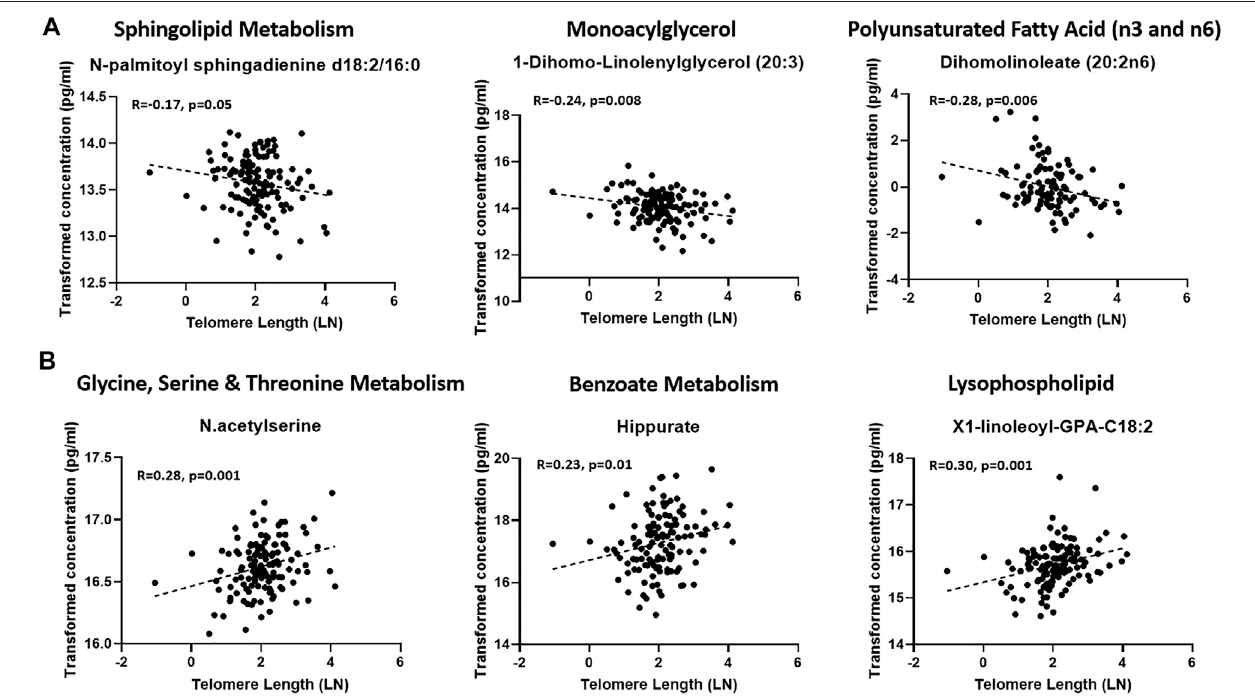
FIGURE 3 | Scatter plots of representatives of enriched pathways that were reduced (A) or increased (B) with LTL.